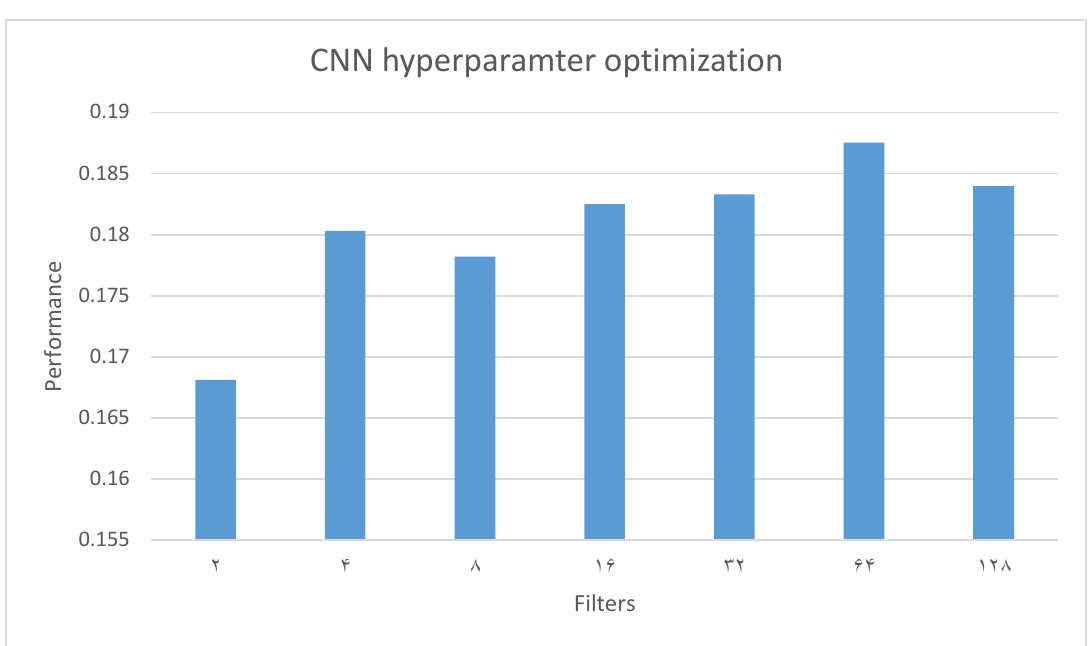
Figure A-4 Optimized number of Filters in the Convolution Layer of CNN